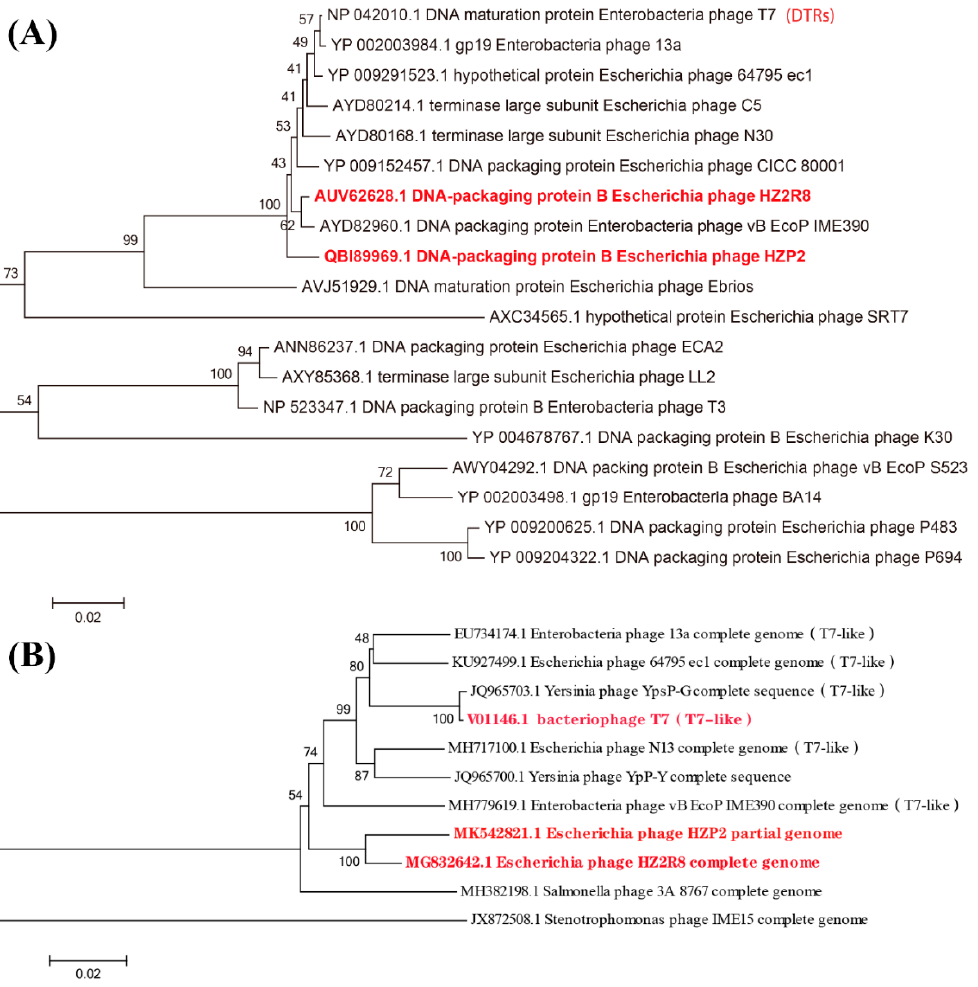
Figure 5. ( A ) Phylogenetic tree of various phages based on large terminase subunit. ( B ) Phylogenetic tree of various phages based on DNA polymerase.